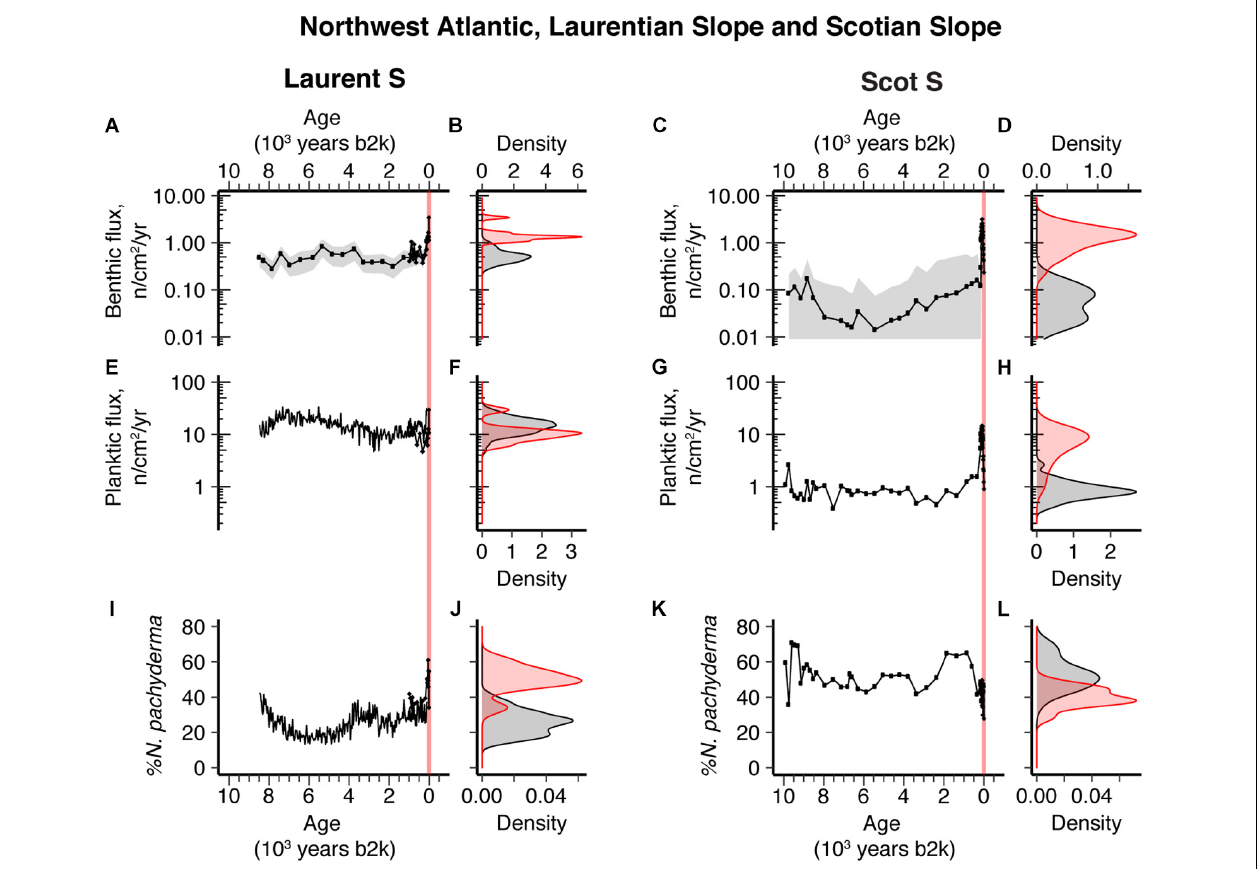
FIGURE 5 | Ten thousand-year northwest Atlantic sediment records and density distribution plots comparing the distribution of Holocene (black) versus industrial era (red) data from Laurent S (A,B,E,F,I,J) and Scot S (C,D,G,H,K,L) . (A–D) Benthic foraminifer flux; (E–H) planktic foraminifer flux; (I–L) Neogloboquadrina pachyderma % abundance. Vertical red-shaded band indicates industrial era. Gray-shading in the benthic flux time series plots represents 2 σ